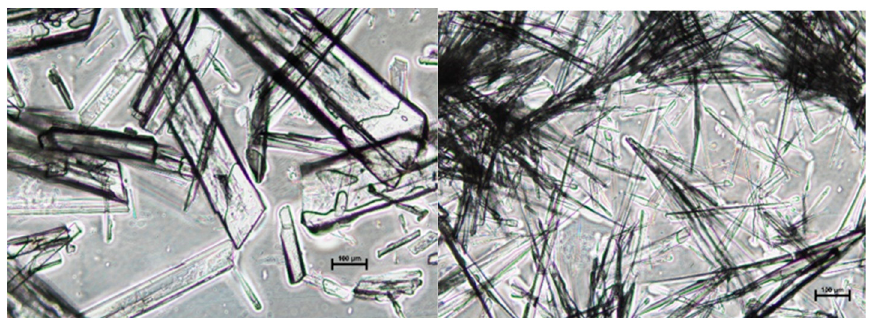
Figure 6. Product formation in the combined triple vessel concept; 30 °C, 25 mM HEPES buffer pH 7.5, 100 mM 3MAP, 60 mM IPA-3DPPA, 100 mM additional isopropylamine and 5 mM PLP (within entire solution).